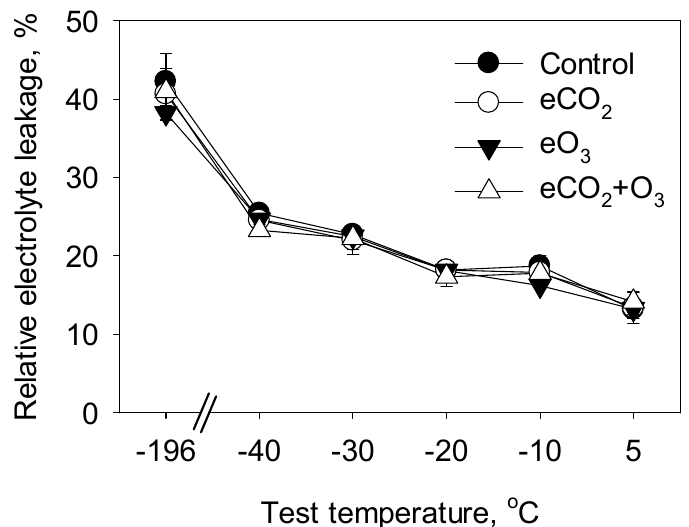
Figure 2. Effect of elevated CO 2 (eCO 2 ), elevated O 3 (eO 3 ) and eCO 2 + eO 3 on the relative electrolyte leakage (REL) in the paper birch buds after the freezing test. The buds were sampled on May 4, 2009, after 11 growing seasons of the exposure treatments (1998–2008). Mean values ( ± SE, n = 3) are presented.